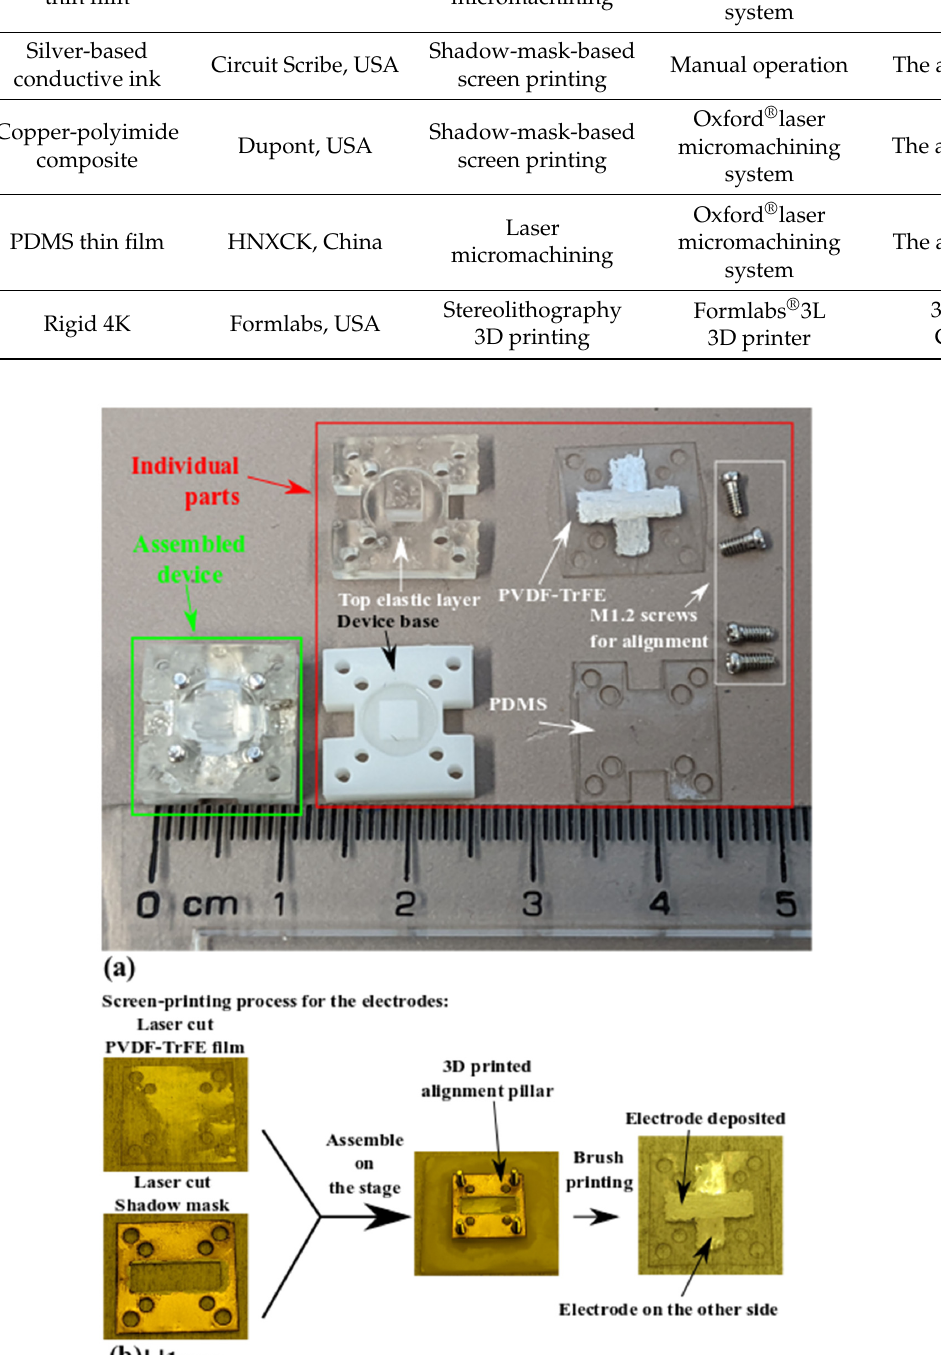
Figure 4. Fabricated device and parts. ( a ) An assembled tactile sensor and separate individual components; ( b ) Screen printing process to make the electrode layers on the bottom and top surface of the PVDF-TrFE film.